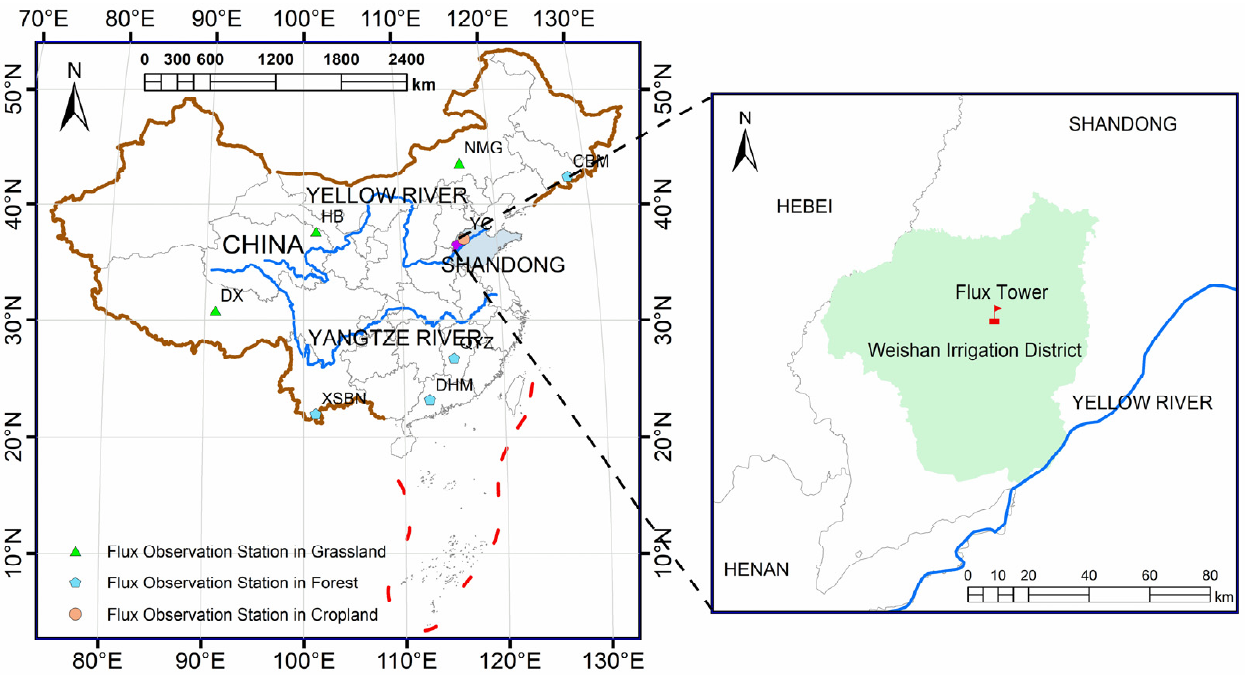
Figure 1. The geographical location of the study area. Changbai Mountain (CBM); Dinghu Mountain (DHM); Dangxiong (DX); Haibei (HB); Neimenggu (NMG); Qianyanzhou (QYZ); Xishuangbanna (XSBN); Yucheng (YC).